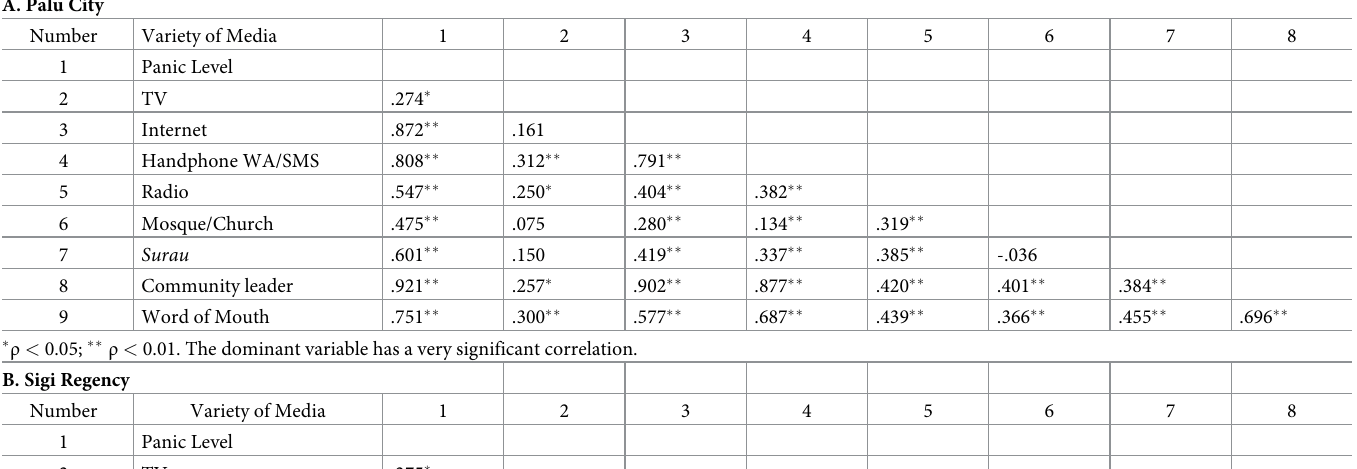
Table 4. Results of correlation analysis between media types and the panic level of affected communities in Palu (A), Sigi (B) & Donggala